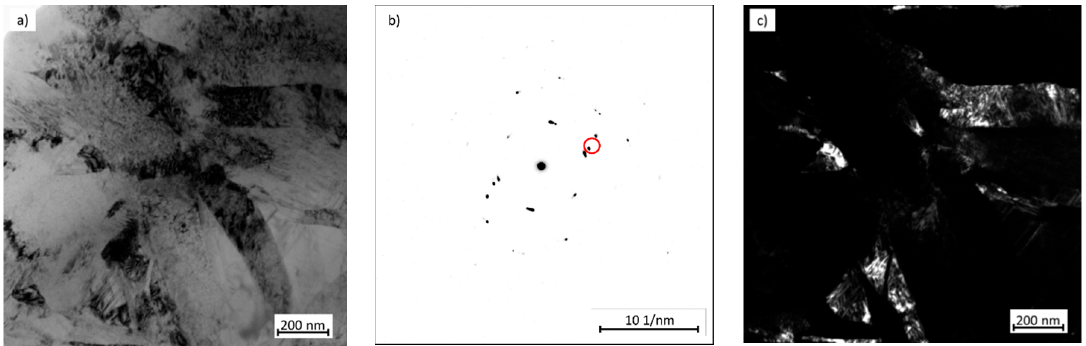
Figure 12. Regime 3: 1240 °C/water: ( a ) BF micrograph; ( b ) related SAED pattern with a reflection of γ Fe austenite (red) used for DF imaging; ( c ) DF micrograph showing the distribution of retained austenite.